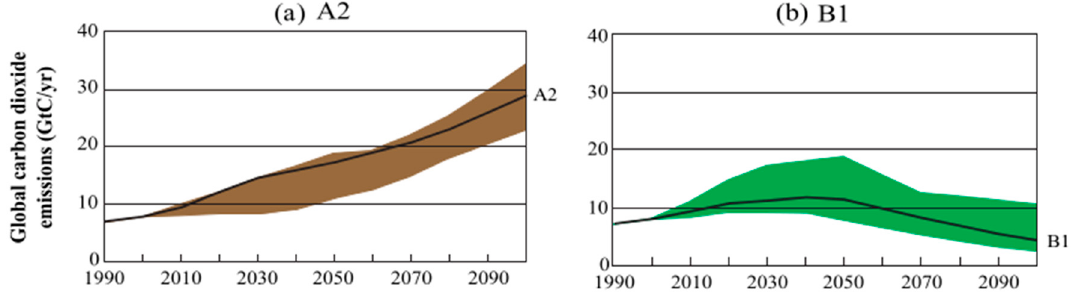
Figure 1. Future projection of global carbon dioxide emission for the ( a ) A2 and ( b ) B1 scenarios from SRES. From Nakicenovic et al. (2000)